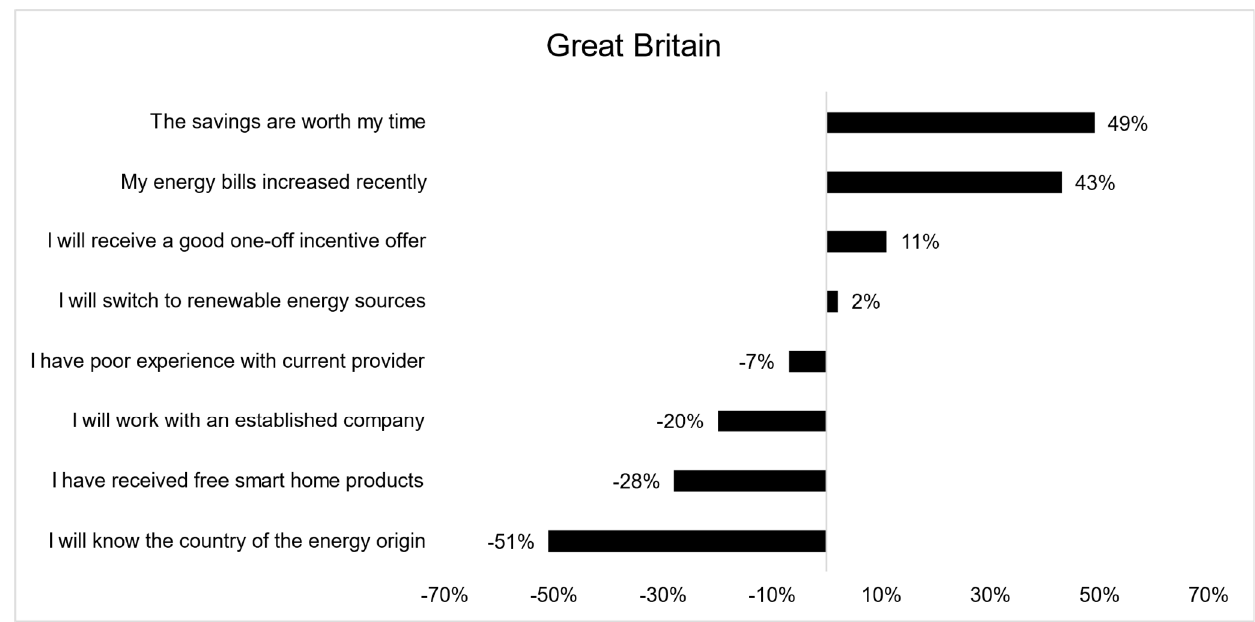
Figure 3. Utility attributes for various energy provider reasons in Great Britain. Source: own study.